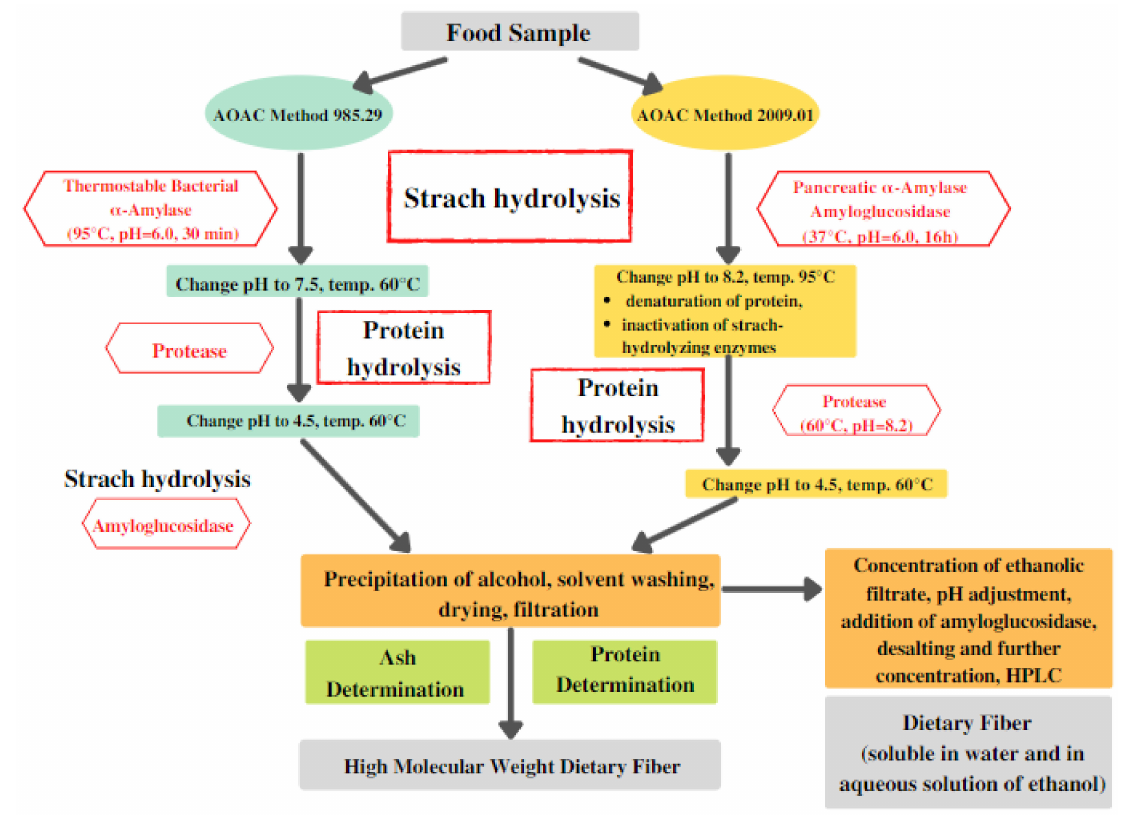
Figure 3. Main steps involved in the determination of dietary fiber. AOAC: Association of Official Analytical Collaboration; HPLC: High-performance liquid